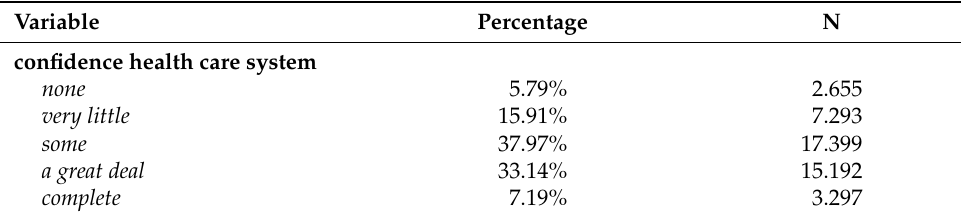
Table 4. Description of categorial variables, N =